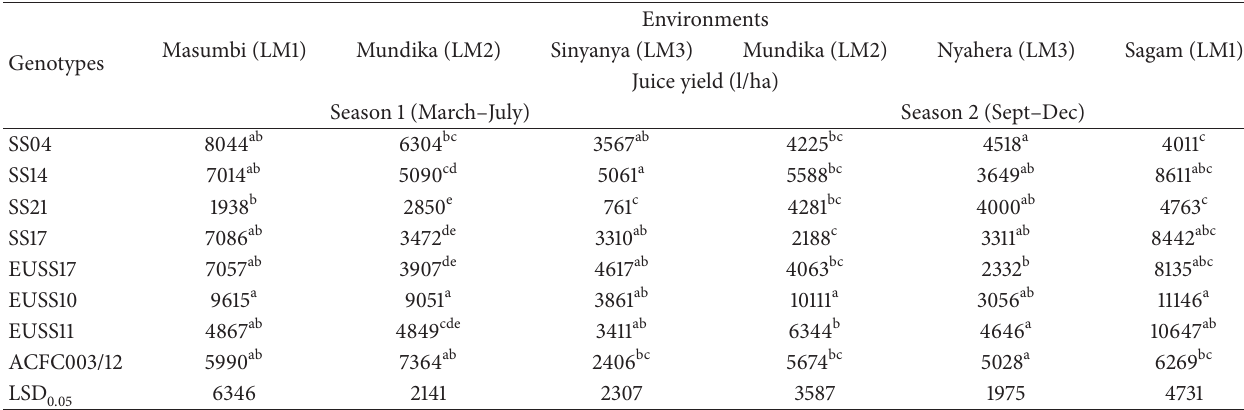
Table 5: Juice yield (l/ha) of eight sweet sorghum genotypes across environments.